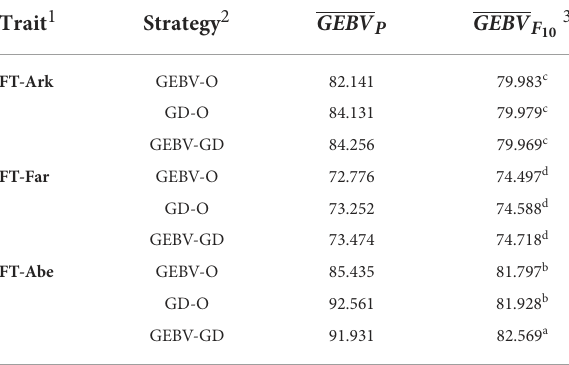
TABLE 3 GEBV averages of the best F 10 inbred lines for the 44k rice dataset based on the index weights of 1/3, 1/3, and 1/3. Trait 1